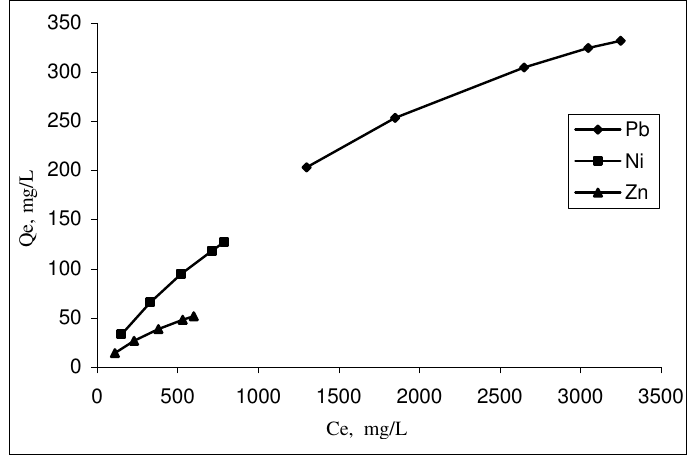
Figure 1 . Variation of the amount of Pb 2+ , Ni 2+ and Zn 2+ adsorbed with equillibrium concentration. Table 1. Ionic character of Pb 2+ , Ni 2+ and Zn